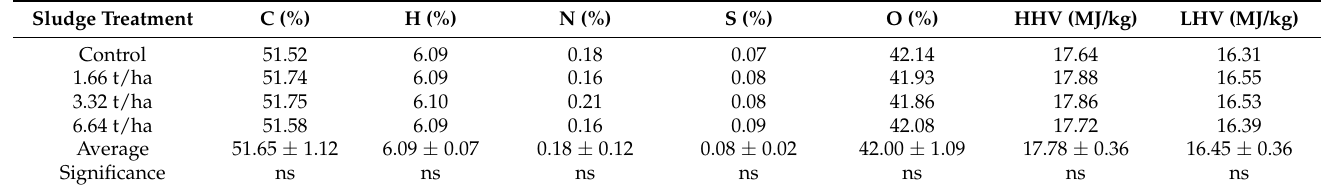
Table 5. Elemental analysis of Miscanthus biomass fertilized with different dosages of municipal sewage sludge. Sludge